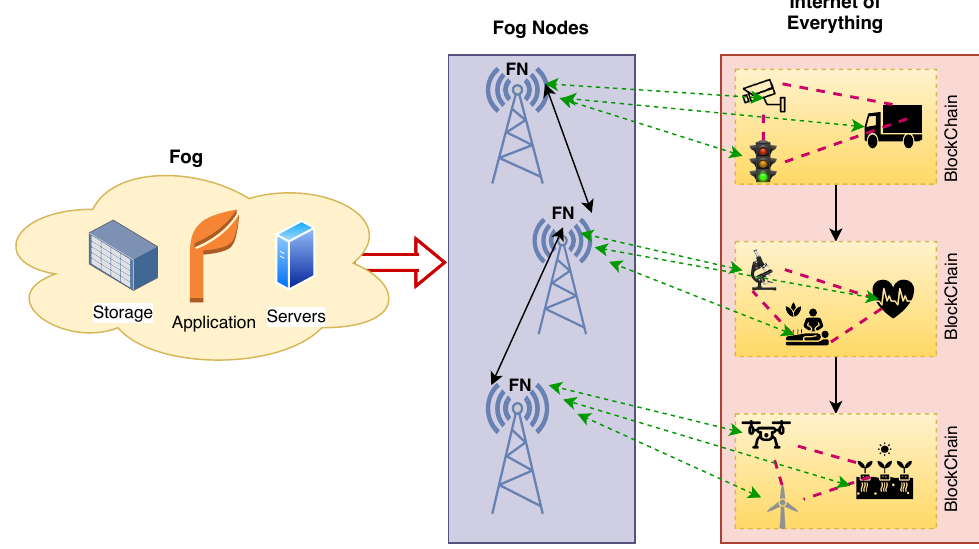
Figure 2. Blockchain based fog supported architecture for smart